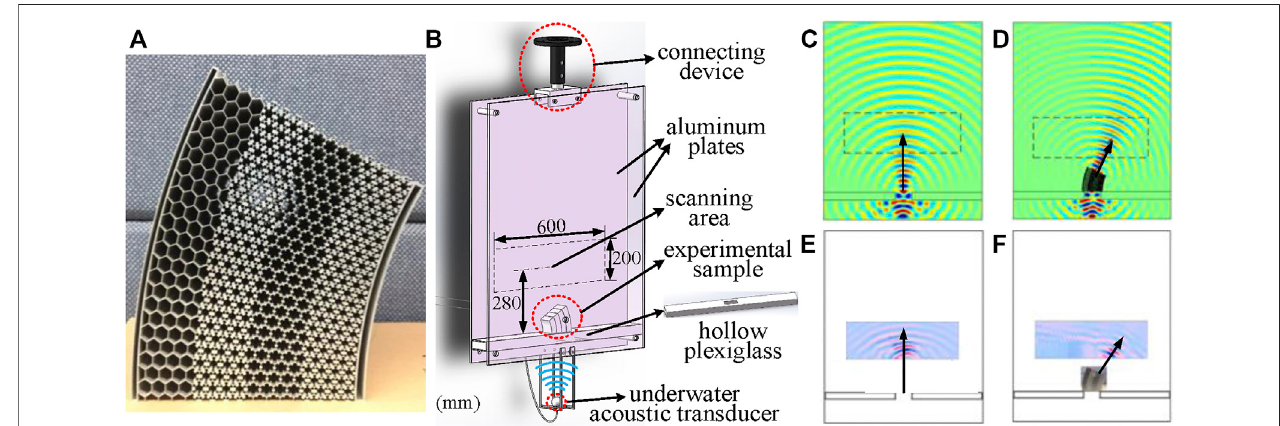
FIGURE 5 | (A) The experimental sample of the acoustic waveguide with anisotropy density and a thickness of 50 mm. (B) 2D underwater acoustic waveguide experimentaldevice.Thelength,widthandthicknessoftwoparallelaluminumplatesare1000,800and10 mm,respectively,andthedistancebetweenthetwoplatesis 50 mm. The part enclosed by the black dotted line is the acoustic fi eld scanning area, its length and width are 600 and 200 mm respectively, and its geometric center is 280 mmawayfromthebottomofthesample. (C) Pressuremapofthefreespacesimulatedat20 kHz. (D) Pressuremapoftheacousticwaveguidewithanisotropy density simulated at 20 kHz. (E) Measured pressure of the free space at 20 kHz. (F) Measured pressure of the anisotropy-density acoustic waveguide at 20